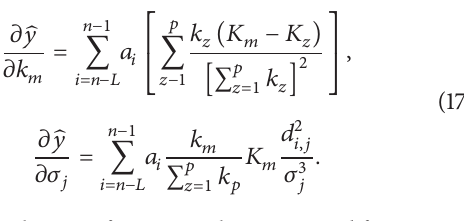
Figure 1: Sallen-Key low pass